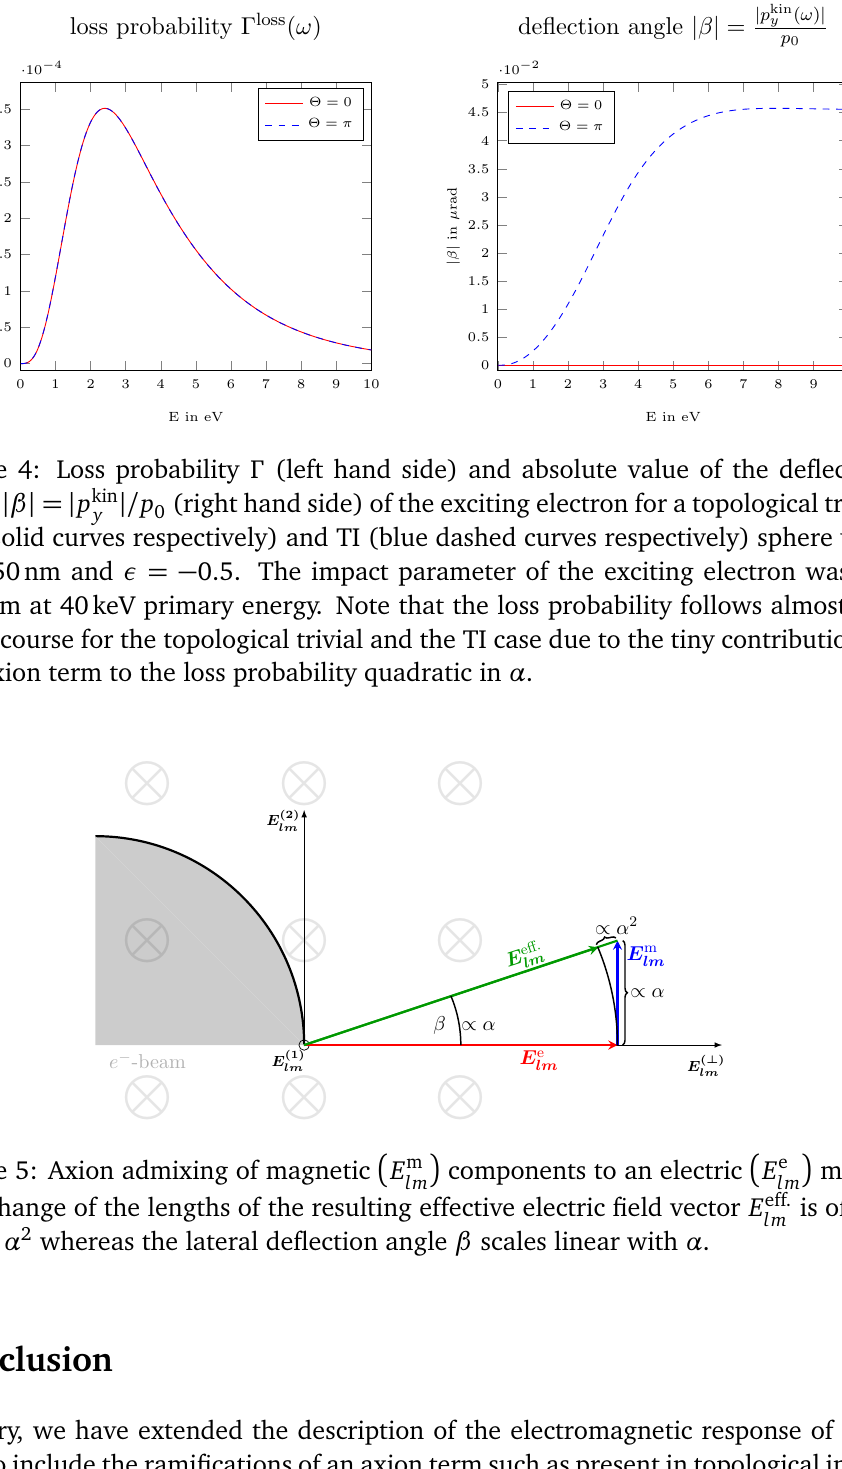
Figure 5: Axion admixing of magnetic The change of the lengths of the resulting effective electric field vector E eff. order α 2 whereas the lateral deflection angle β scales linear with α